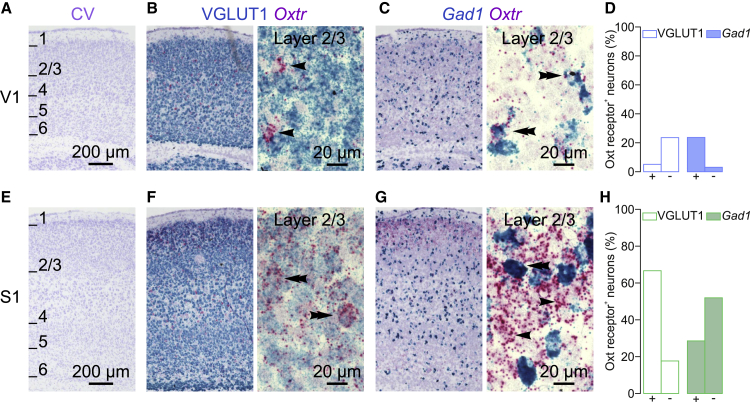
Oxytocin Receptor mRNA Is Differentially Expressed across Sensory Cortices(A) Cresyl violet Nissl staining of a sagittal section from V1 at low magnification. Numbers indicate cortical layers.(B) Dual-color RNAscope staining of VGLUT1 and Oxtr mRNA in a V1 sagittal section. Left: low magnification is shown. Right: high magnification is shown. Note that the Oxtr signal was largely non-overlapping with the VGLUT1 signal (arrowheads indicate VGLUT1−/Oxtr+ neurons).(C) Dual-color RNAscope staining of Gad1 and Oxtr mRNA in a V1 sagittal section. Left: low magnification is shown. Right: high magnification is shown; note that the Oxtr signal co-localized with the Gad1 signal (double arrowhead Gad1+/Oxtr+) and not with Gad1− neurons.(D) Quantification.(E) Cresyl violet Nissl staining of a sagittal section from S1 (same section as in A) at low magnification. Numbers indicate cortical layers.(F) Dual-color RNAscope staining of VGLUT1 and Oxtr mRNA in an S1 sagittal section. Left: low magnification is shown. Right: high magnification is shown; note the superposition of the two signals (double arrowheads, VGLUT1+/Oxtr+).(G) Dual-color RNAscope staining of Gad1 and Oxtr mRNA in an S1 sagittal section. Left: low magnification is shown. Right: high magnification is shown; note that the Oxtr signal co-localized with both Gad1+ and Gad1− signal (double arrowheads indicate Gad1+/Oxtr+; arrowhead indicates Gad1−/Oxtr+ neuron).(H) Quantification.